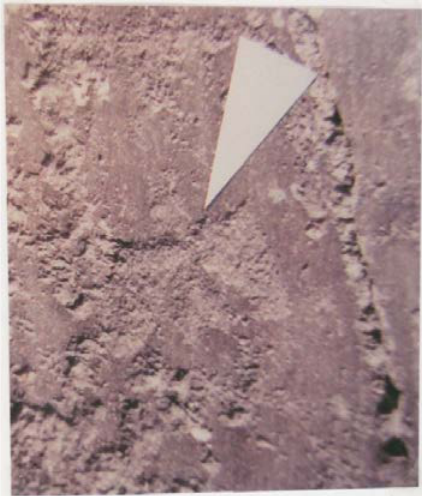
Figure 16. A solidly pecked thunderbird on the main panel at the Hensler Petroglyph Site.